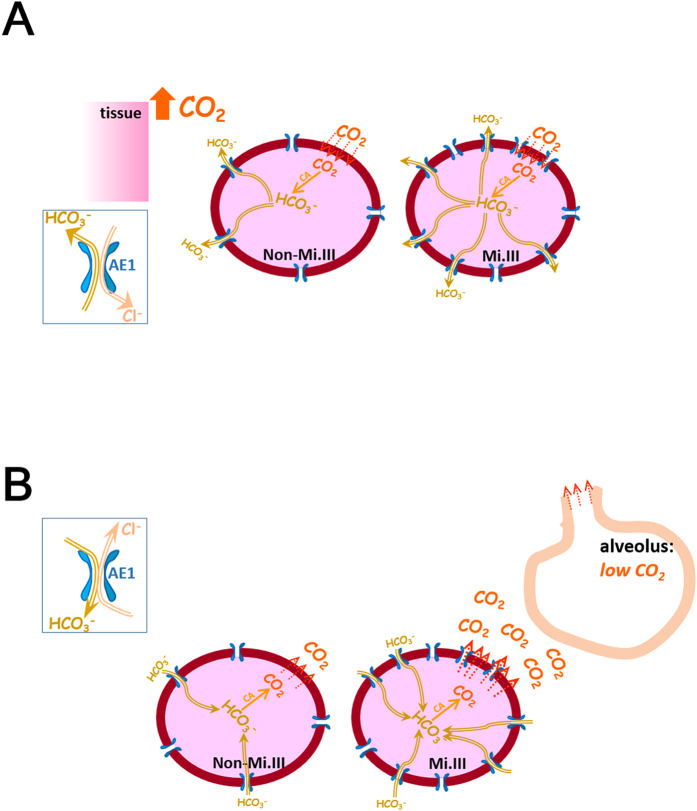
A proposed model on how CO2 expiration could be faster in people bearing the Mi.III blood type than those lacking this phenotype.(A) During exercise, there is increasing CO2 output, along with an increasing demand for ATP expenditure from contracting muscles. CO2 produced by muscle tissues enters erythrocytes primarily through passive diffusion (shown in red dotted arrows). Erythrocytes contain abundant carbonic anhydrase, which functions to greatly accelerate the chemical conversion between CO2 and HCO3−. Inside circulating red cells in this vicinity, CO2 is rapidly converted to HCO3− by carbonic anhydrase. Much HCO3− produced is passively transported out of RBCs via AE1 (shown as the blue gates embedded on the cell membrane). For every bicarbonate ion moving out of RBCs through AE1, a Cl− ion is transported into RBCs to maintain electroneutrality across the cell membrane. The direction and magnitude of anion transport via AE1 follow the Donnan equilibrium, and thus this bi-directional anion transport does not consume energy. Mi.III RBCs express significantly more AE1 molecules on the membrane, allowing more efficient export of bicarbonate and faster reach of HCO3− homeostasis across the cell membrane. (B)  drops to below 40 mmHg in the lungs. The  differences between lung alveoli and capillaries drive CO2 expiration. As most blood CO2 is present in the form of HCO3−, there is tremendous driving force for HCO3− to be converted into CO2 in the lungs. Notably, the enzymatic activity of carbonic anhydrase to convert HCO3− into CO2 is much faster than the rate of bicarbonate transport through AE1. Larger bicarbonate influxes into Mi.III RBCs that express more AE1, and consequently faster CO2 production and expiration are expected from Mi.III+individuals. The directionality of HCO3−/Cl- fluxes through AE1 reverse from tissues to lungs, which is primarily driven by the changes of HCO3− concentration gradients across the red cell membrane (as shown left in boxes). The diagram here is intended to illustrate the mechanism of how Mi.III expression could impact physiologic CO2 respiration, and is not drawn to scale.